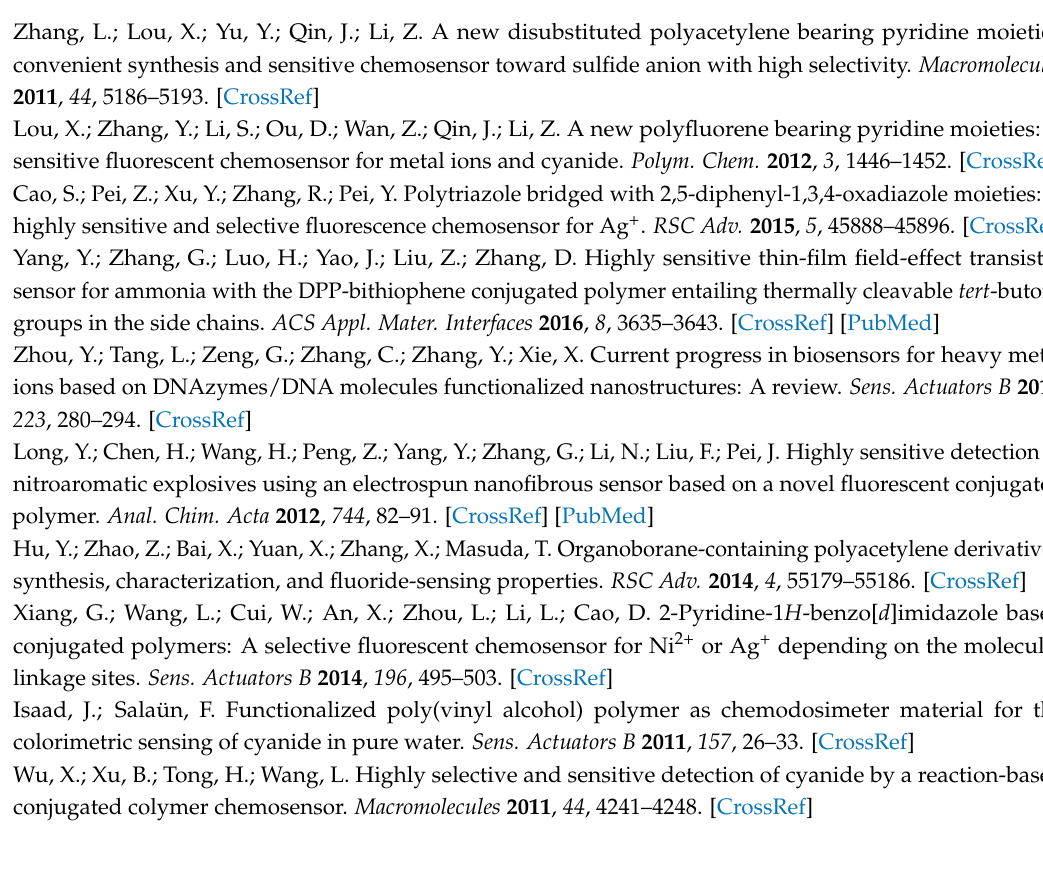
Figure S1: 1 H NMR spectra of monomers (a) 1 and (b) 3. Figure S2: FABMS of monomer 4. Figure S3: 1 H NMR spectra of polymers (a) PC2Br and (b) PCaT. Figure S4: TGA curves of PC2Br and PCaT. Figure S5: Energy dispersive spectroscopy (EDS) data of polymer PCaT-Fe 3+ in THF. Figure S6: Dynamic light scattering (DLS) measurement of PCaT in